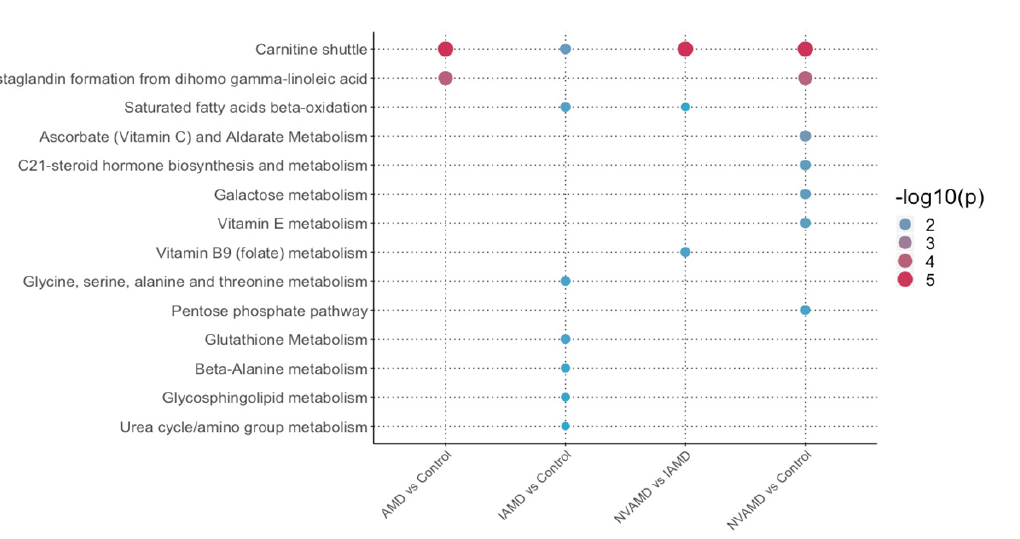
Figure 4. Plasma steroid-related metabolites altered in AMD patients. Plasma levels of the steroid-related metabolites cortexolone and 25-hydroxyvitamin D2 were altered in AMD patients. Kruskal–Wallis tests were used for pairwise com- parisons and p -values are shown above comparison brackets. The molecular identities of these metabolites have been confirmed at MSI level 2.